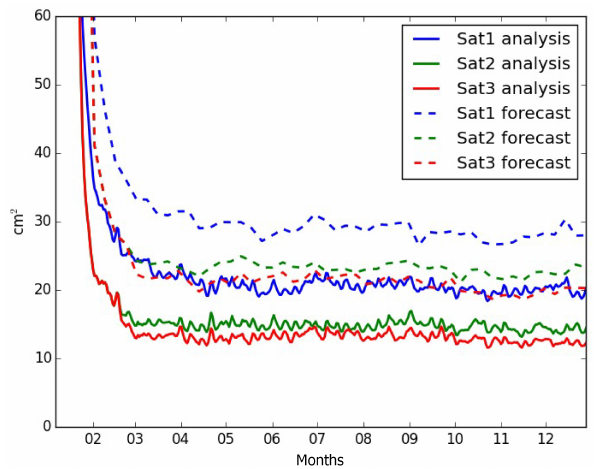
Figure 3. Time evolution of the global MSE of SL in cm 2 for both analyses (plain lines) and 7-day forecasts (dashed lines) for Sat1 (blue), Sat2 (Green) and Sat3 (Red).